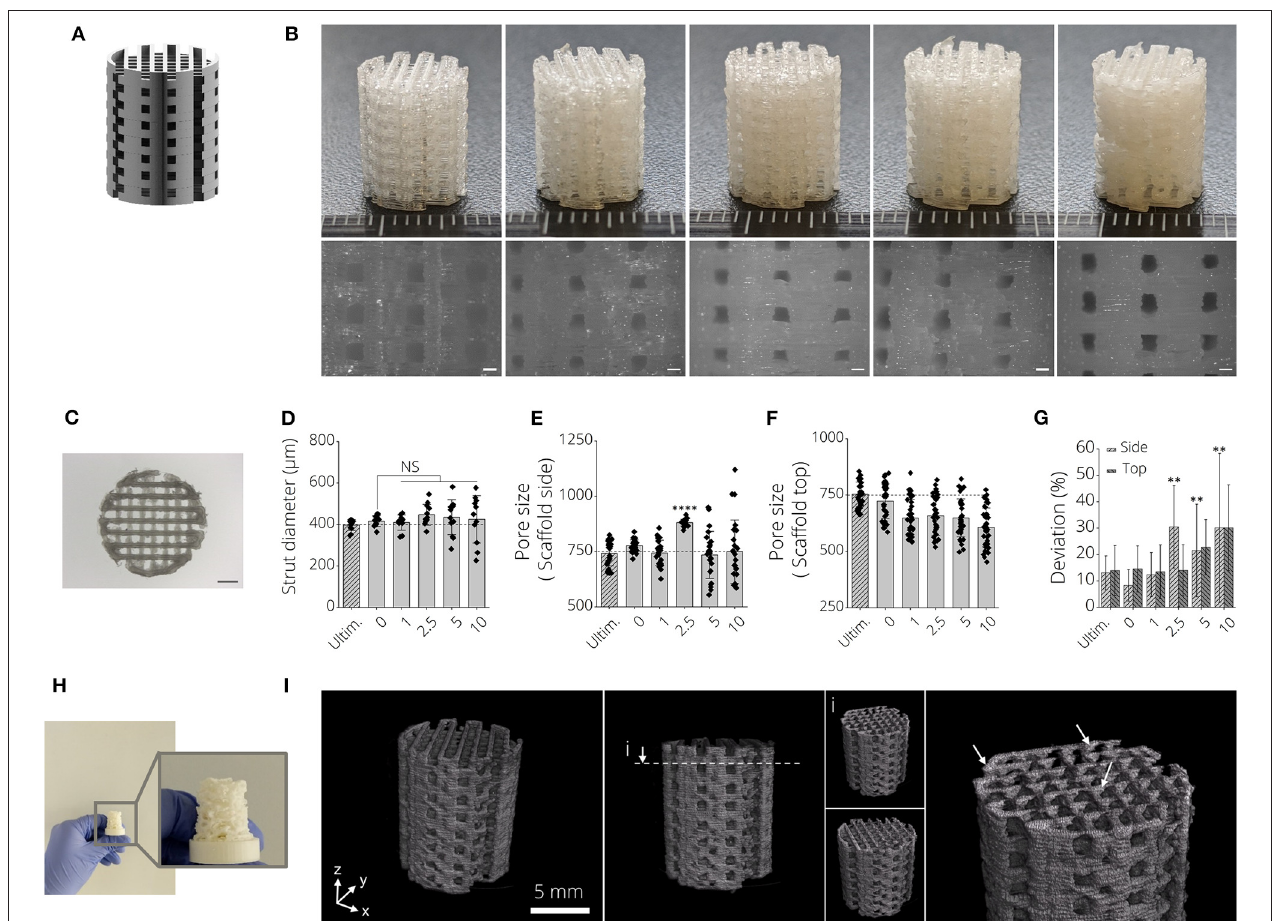
FIGURE 3 | 3D printed PLA-45S5 BG scaffolds. (A) CAD render of the aimed design for PLA-BG scaffolds with a pore size of width = 750 µ m. (B) FDM 3D printed PLA-BG scaffolds from prior produced filaments. From left to right: PLA-0% (wt) BG, PLA-1%(wt) BG, PLA-2.5% (wt) BG, PLA-5% (wt) BG, and PLA-10% (wt) BG 45S5. Light microscopy images display the scaffold sides (bottom). Scale bars: 500 µ m. (C) Top view light microscopy image of a PLA-BG scaffold. Scale bar: 2mm. (D–G) Printability assessment and porosity analysis of PLA-BG scaffolds compared to Ultimaker PLA reference filaments depicting (D) strut diameter, (E) porosity at the side and top (F) of the scaffolds, as well as (G) the deviation of pore area from the theoretical pore area calculated from the CAD model as a measure of printing accuracy. ** p < 0.01, **** p < 0.0001 indicate statistical significant difference of means in comparison to 3D printed 0% BG PLA by one-way ANOVA or Welch’s t -test in pairwise comparisons of scaffold side pore diameter. (H) Print of a complex shaped CAD model based on an upscaled MRI scan of a mouse femur. (I) µ CT image of 3D printed PLA-1% BG scaffold showing the interconnected porosity and indicating even distribution of BG in the scaffolds (white